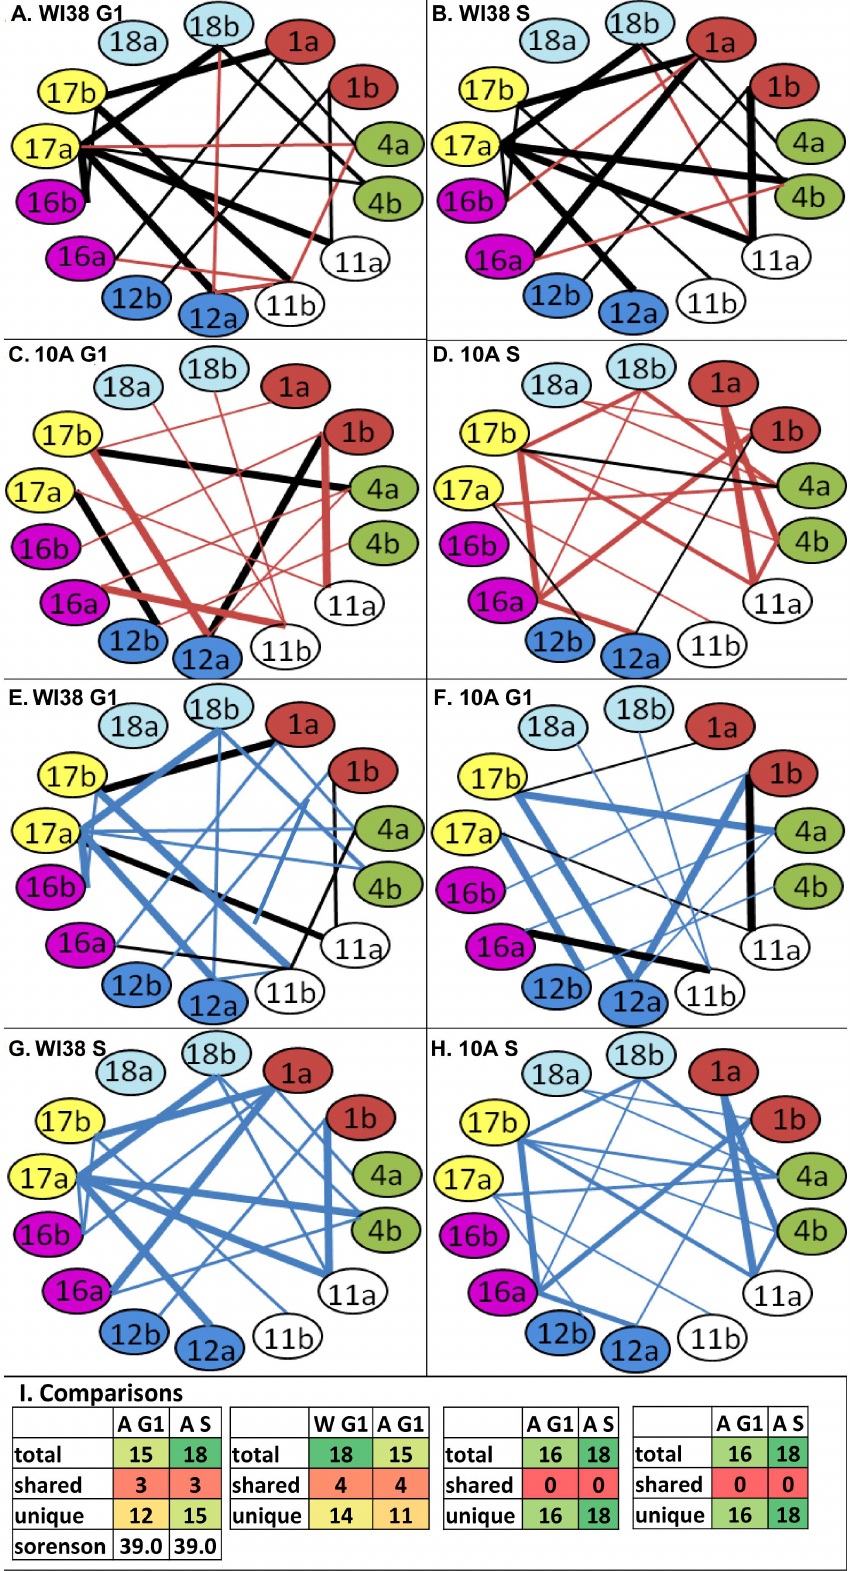
Figure 6. Preferred probabilistic network models of chromosome interactions in the cell cycle of WI38 and 10A. Thresholding of the WI38 (32%) and 10A (31%) matrices above a level where there are no connections in random simulations or randomizations of input matrices or random simulations level interactions (Fig. S9) reveals 14–18 CT interactions in G1 of WI38 ( A, E ), S of WI38 ( B, F ), G1 of 10A ( C, G ), and S of 10A ( D,